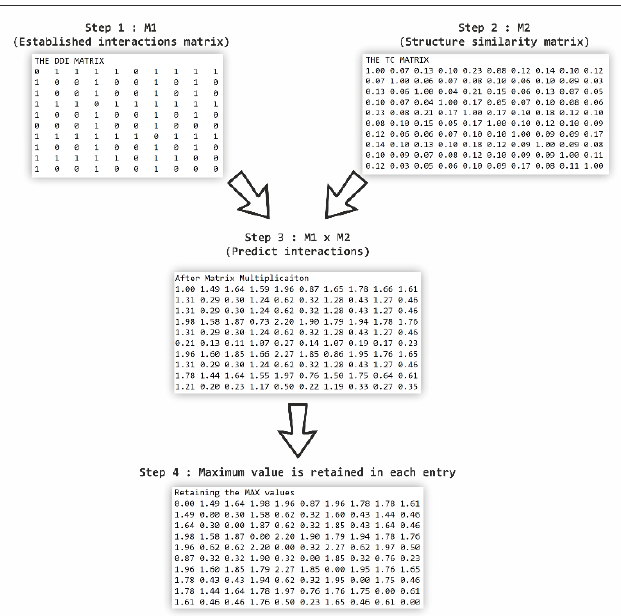
Figure 5.3. Flowchart for DDI